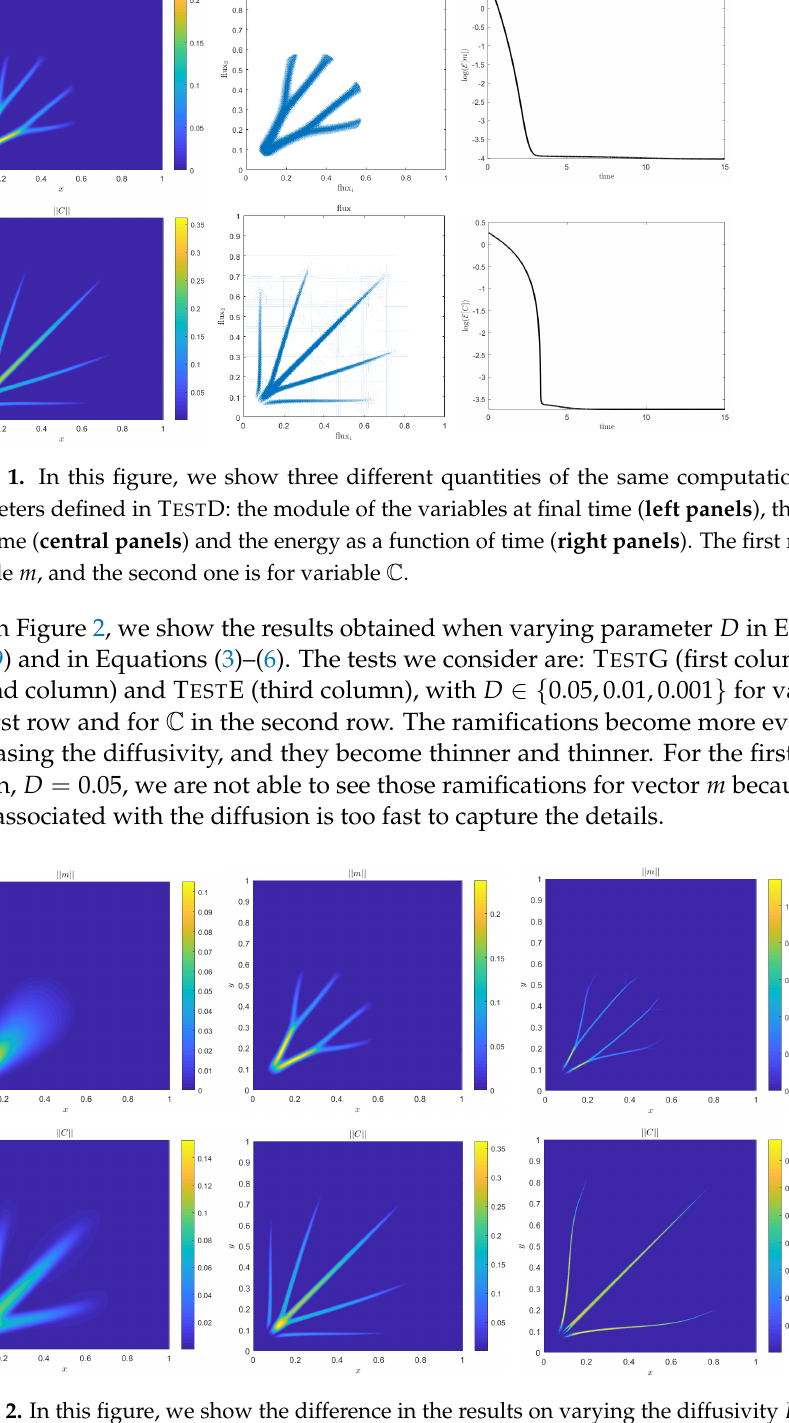
Figure 2. In this figure, we show the difference in the results on varying the diffusivity D . In the first column, we have the results of T EST G ( D = 0.05); in the second column, we choose the parameters of T EST D ( D = 0.01), and in the third one, T EST E ( D = 0.001). The first row shows the results of variable m , and the second row shows those of variable C